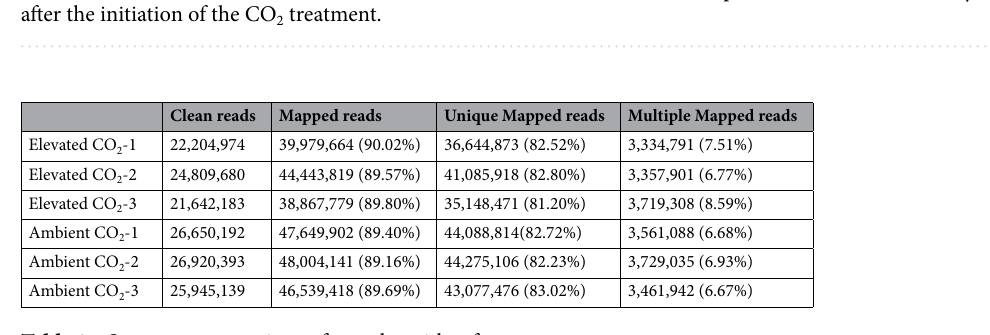
Table 2. Sequence comparison of samples with reference genome.